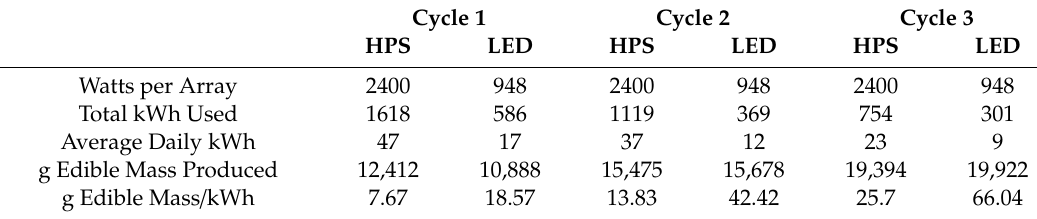
Table 9. Electrical use and biomass e ffi cacy of lettuce in phase 1 in which plants were grown under (kWh) used and total edible biomass produced in grams (g) were used to calculate biomass e ffi cacy (g / kWh), a measure of edible mass produced per unit energy consumed.